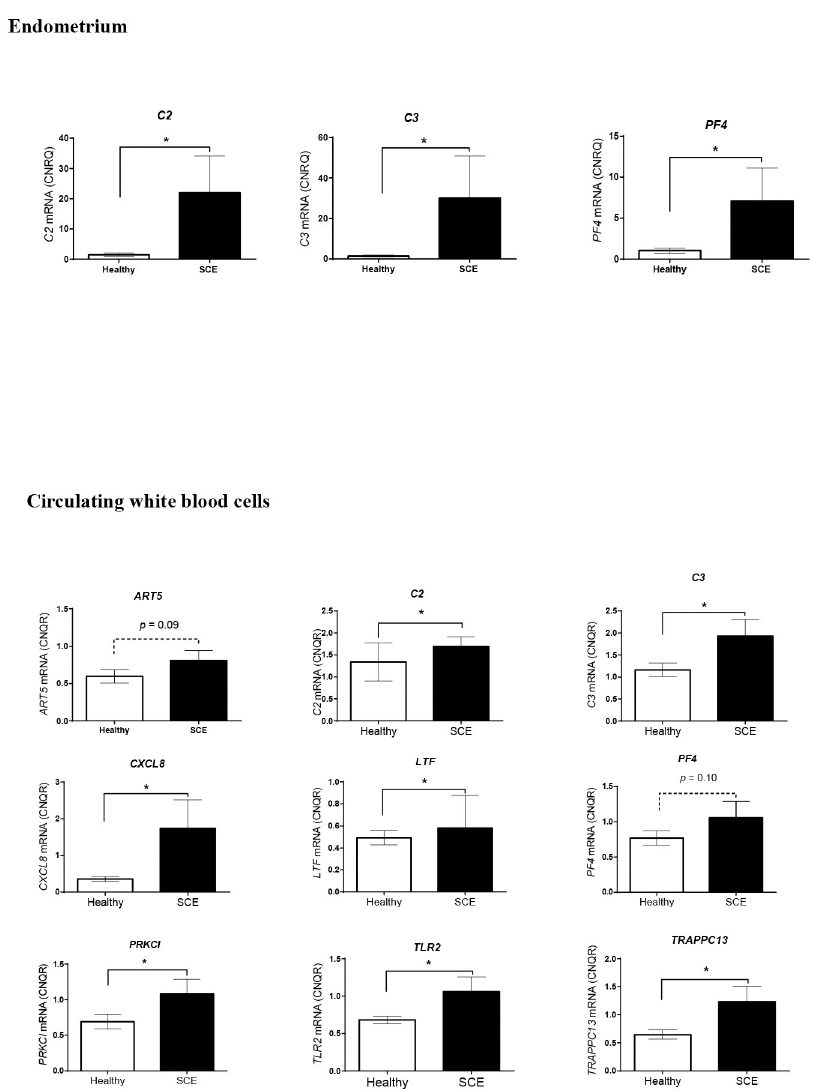
Fig 5. Gene expression in endometrium and circulating white blood cells of Holstein dairy cows at 45–55 days postpartum. In the endometrium, expression levels of C2 , C3 and PF4 , gene transcripts were quantified by RT-qPCR analyses in endometrial biopsies collected from cows with subclinical endometritis (SCE, n = 3 in luteal phase) and from healthy cows (n = 10 including follicular phase, n = 5; luteal phase, n = 5) at 45–55 days postpartum (DPP). Relative gene expression was determined by normalization to the two most stable reference genes ( GAPDH and TPRG1L ). In circulating white blood cells , expression levels of ART5 , C2 , C3 , CXCL8 , LTF , PF4 , PRKCI , TLR2 and TRAPPC13 gene transcripts were quantified by RT-qPCR analyses in cows with subclinical endometritis (SCE, n = 7, including follicular phase, n = 1; luteal phase, n = 4; undetermined estrous cycle, n = 2) compared with healthy cows (n = 10, including follicular phase, n = 5; luteal phase, n = 5) at 45–55 days postpartum (DPP). Relative gene expression was determined by normalization to the two most stable reference genes ( GAPDH and ACTB ). All expression data for gene transcripts of interest are expressed as mean calibrated normalized relative quantity (CNRQ) values in arbitrary units. The significance of differences in gene expression levels between groups of animals was determined by Kruskal Wallis, Dunn’s multiple comparisons test and by Mann Whitney U test at p < 0.05. Results are mean ±